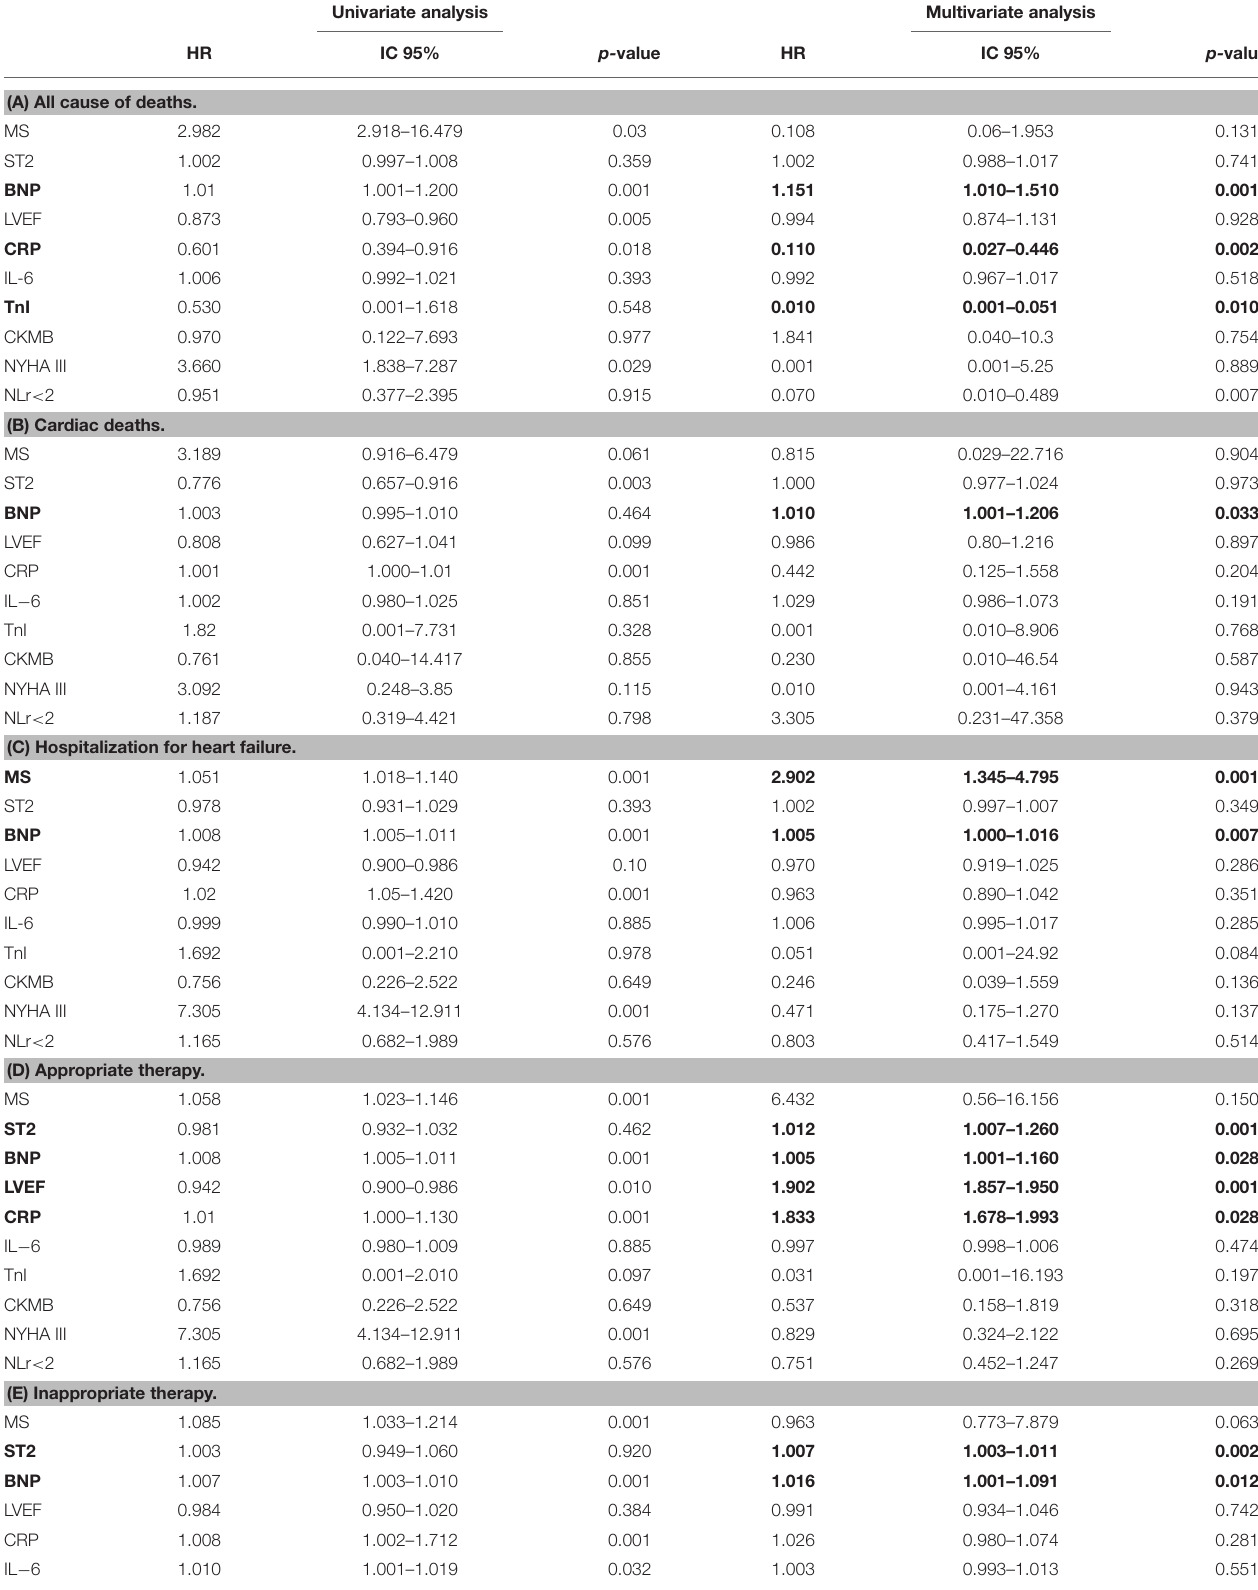
TABLE 4 | Cox regression analysis for study